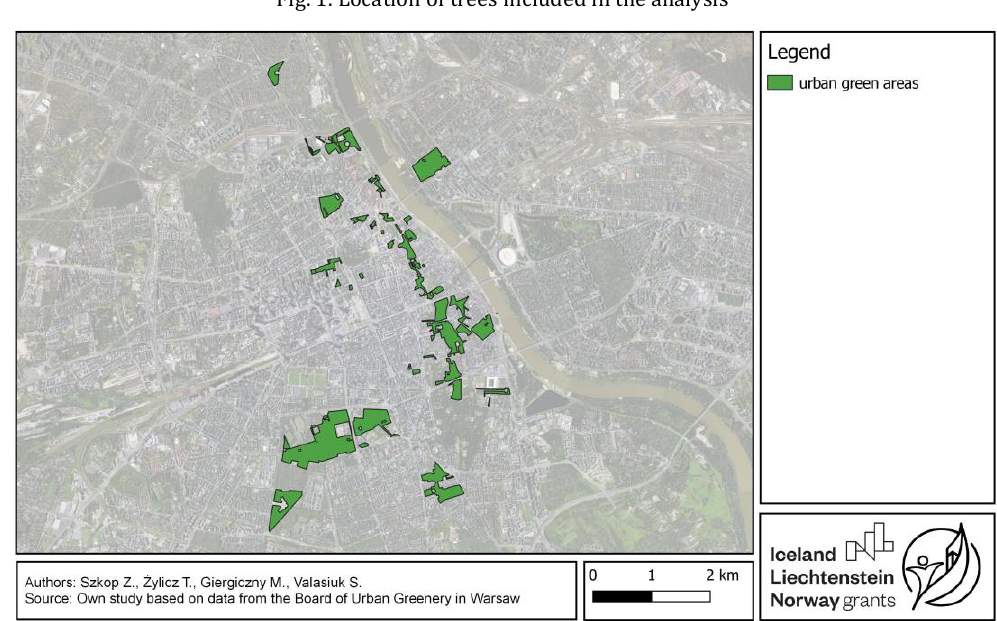
Fig. 2. Analyzed urban green